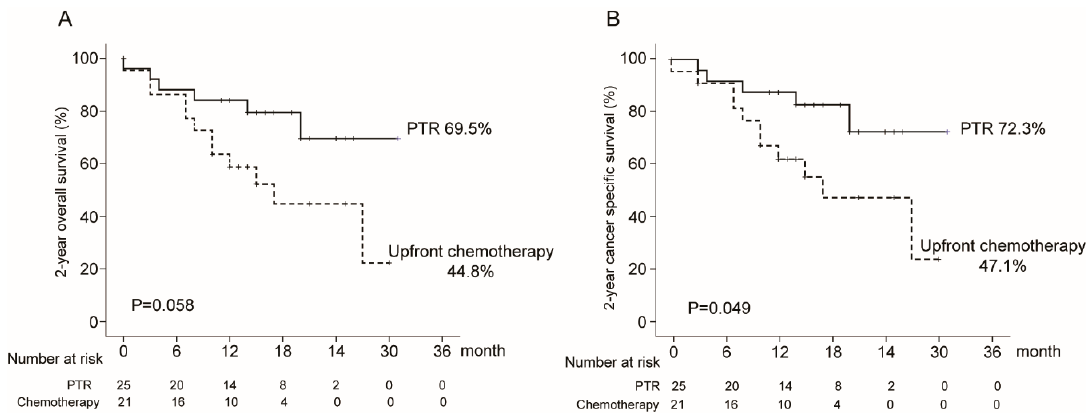
Figure 2. Two-year overall survival: ( A ) Overall survival rate; ( B ) Cancer-specific survival rate.